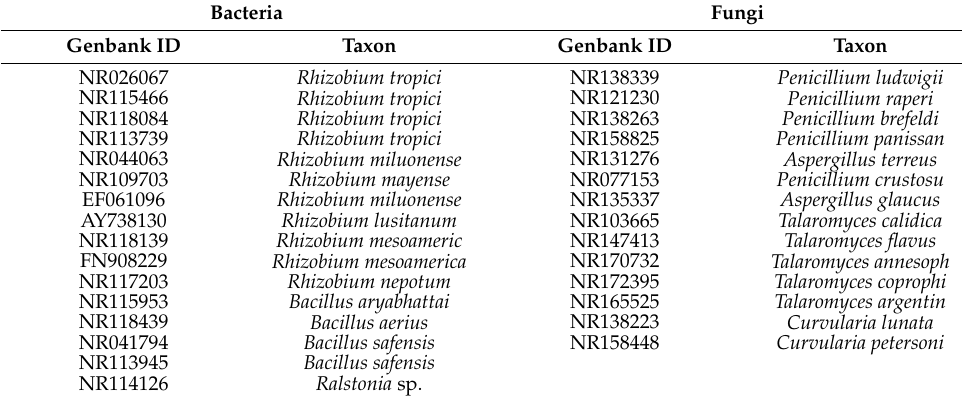
Table 2. Sequence information (Genbank ID) used in this